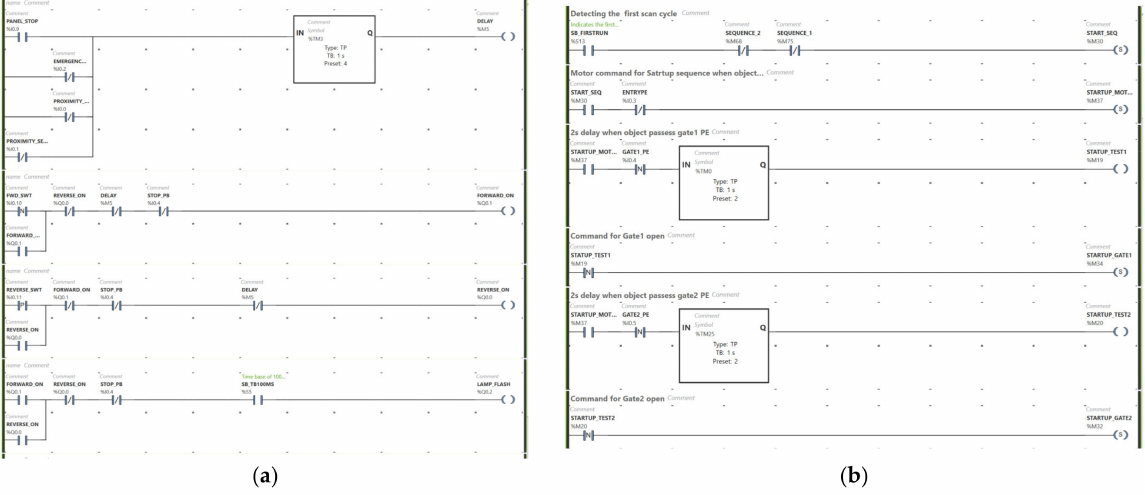
Figure 20. Sample ladder logic programs to test the operation of the experiment hardware. ( a ) Snippet of forward/reverse conveyor program; ( b ) Snippet of Festo sorting machine program.